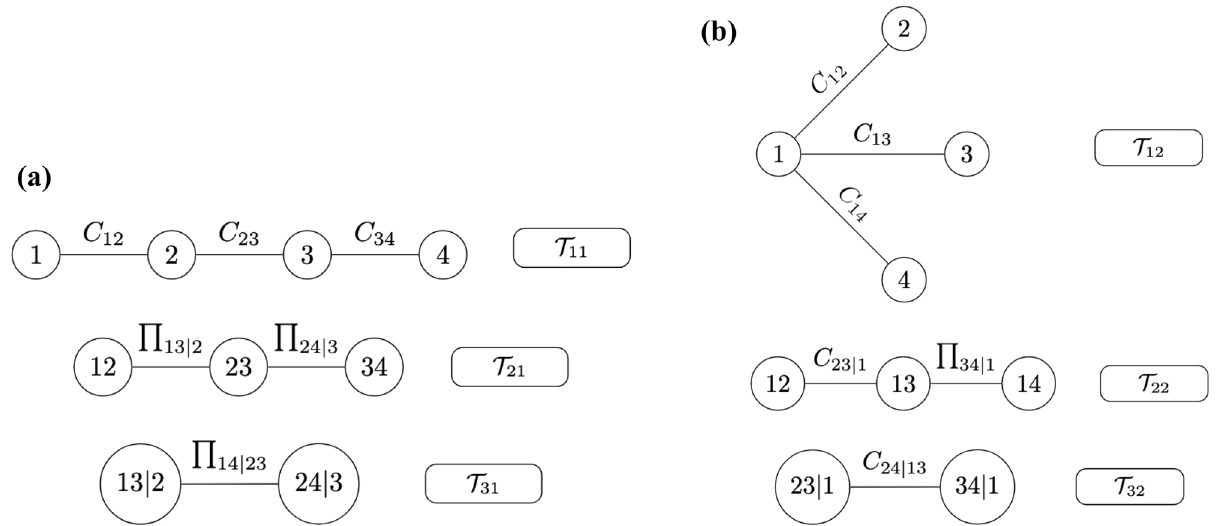
Figure 4. Two-component mixture of R-vine copula densities. ( a ) The left panel represents a 4-dimensional D-vine copula as the first cluster of the mixture model. ( b ) The right panel represents a 4-dimensional C-vine copula as the second cluster of the